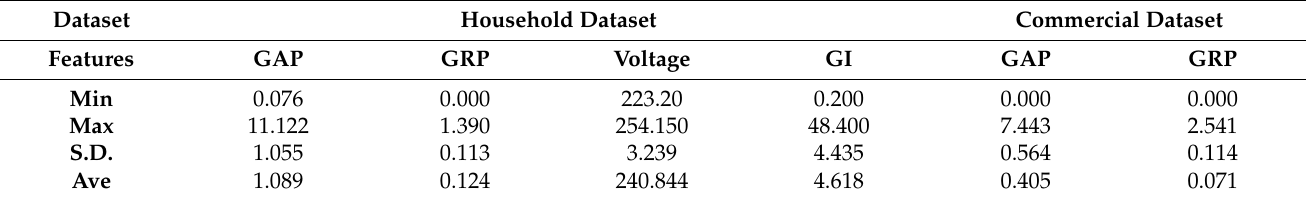
Table 2. Statistics of the datasets including max, min, standard deviation, and average values for the used feature. Dataset Household